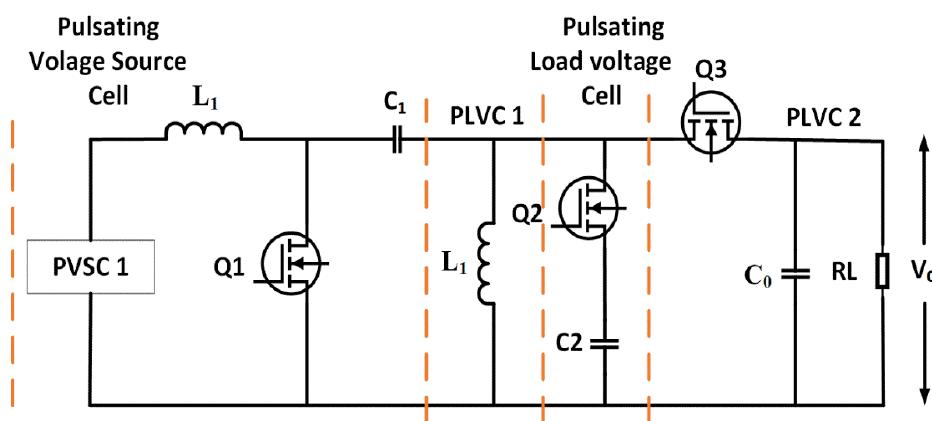
Figure 15. Three-port unidirectional SEPIC converter.